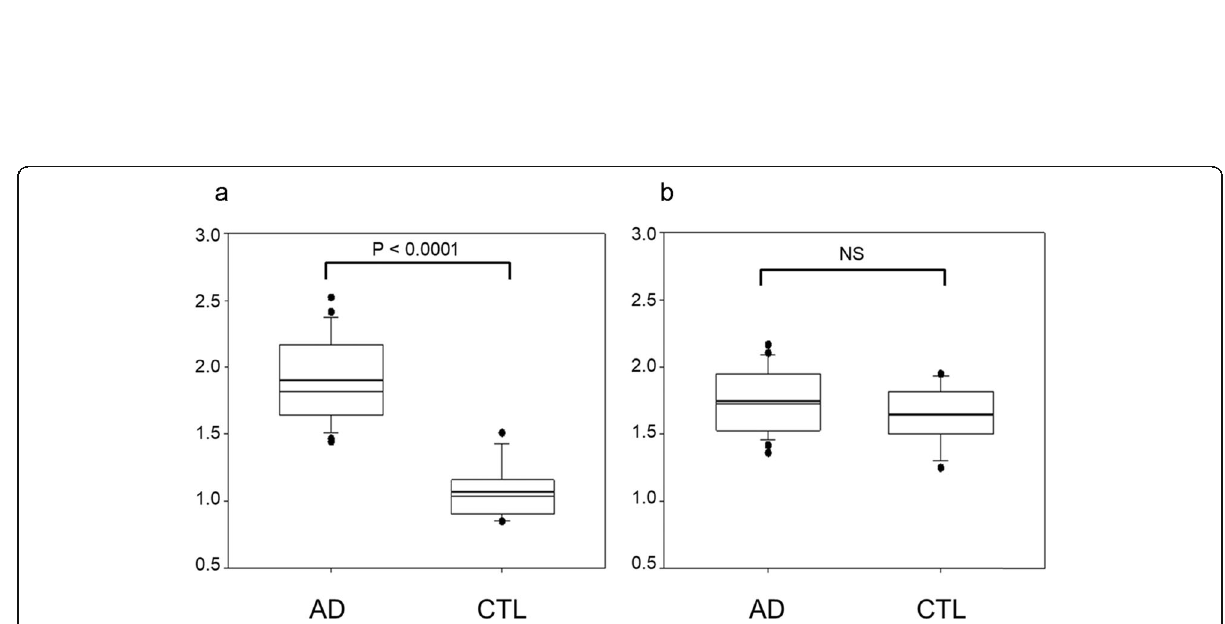
Fig. 3 Average SUVr values of [ 11 C]PiB in cerebral cortex ( a ) and white matter ( b ). The AD group showed significantly greater cortical SUVr than the CTL group ( P < 0.0001); however, white matter accumulation showed no difference between the AD and CTL groups (NS: P > 0.05). Note mean values of CTL were lower in the cerebral cortex than in the white